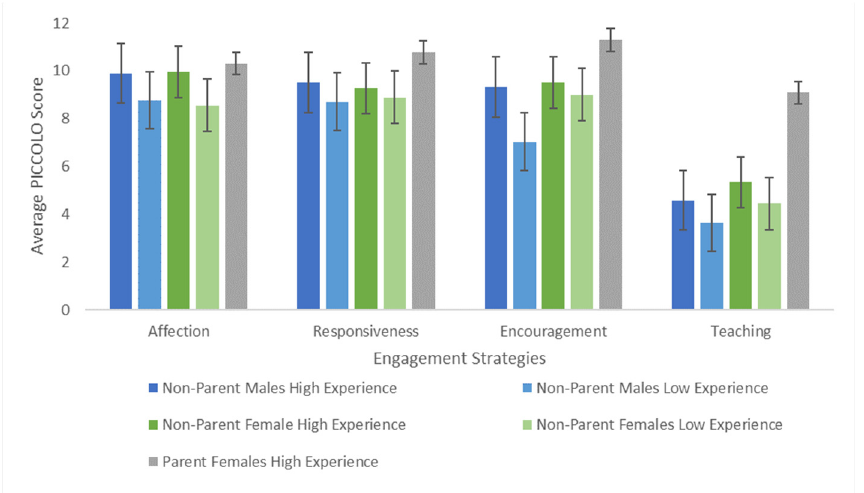
Figure 3. Differences in engagement strategies between interaction partner groups, accounting for experiences with children. Error bars represent Standard Errors. Overall, responsiveness and encouragement are employed more by parents, but employing encouragement is driven by experience rather than gender or parenthood status.